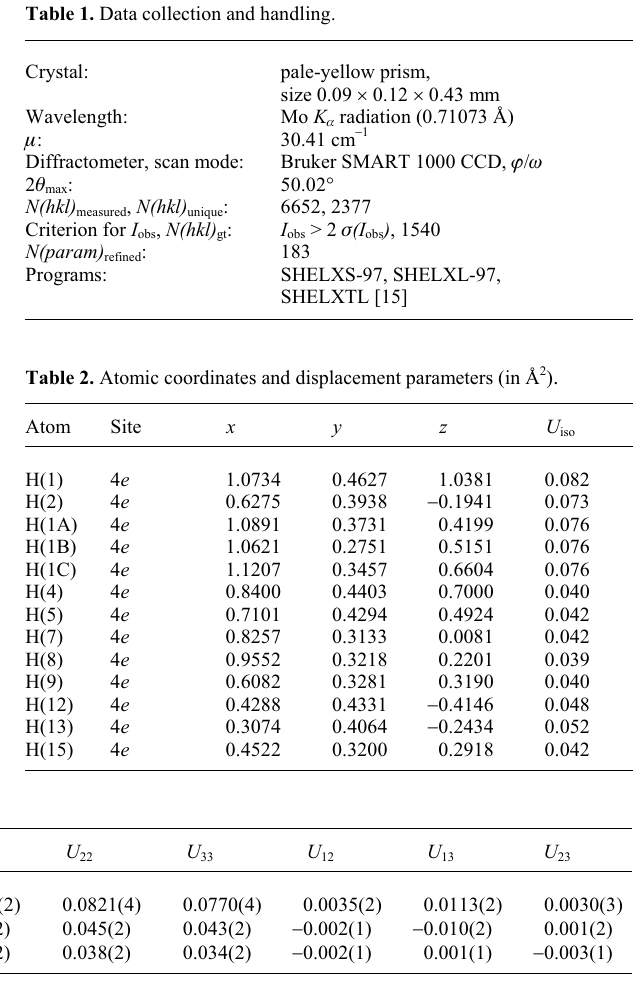
Table 1. Data collection and handling.